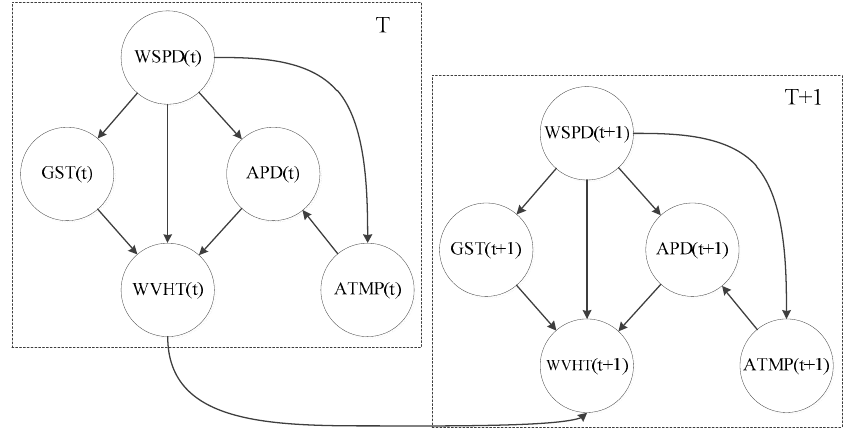
Figure 7. DBN structure of WVHT prediction.